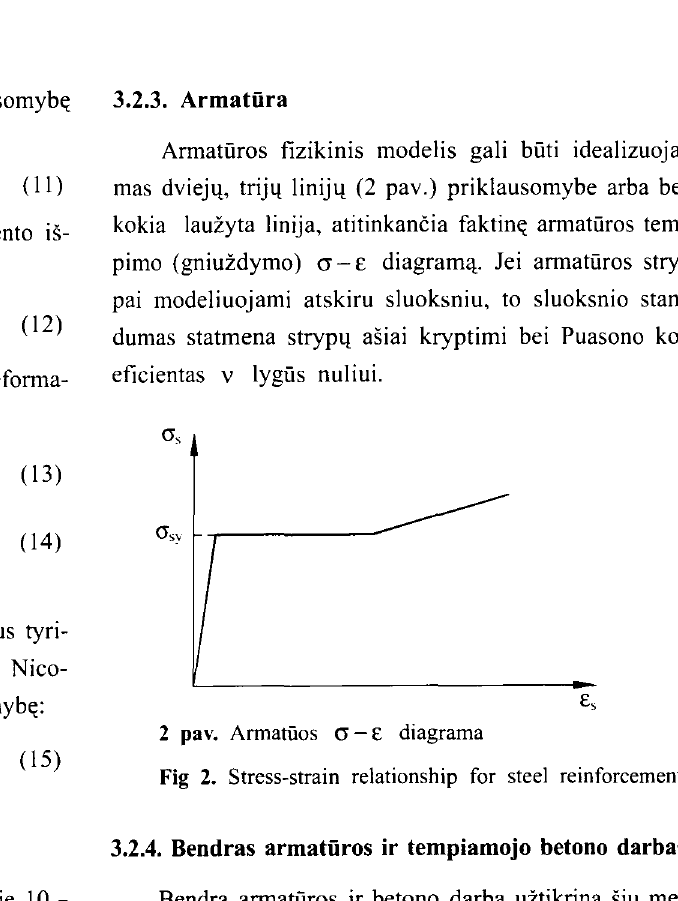
Fig 2. Stress-strain relationship for steel reinforcement 3.2.4. Bendras armatiiros ir tempiamojo betono